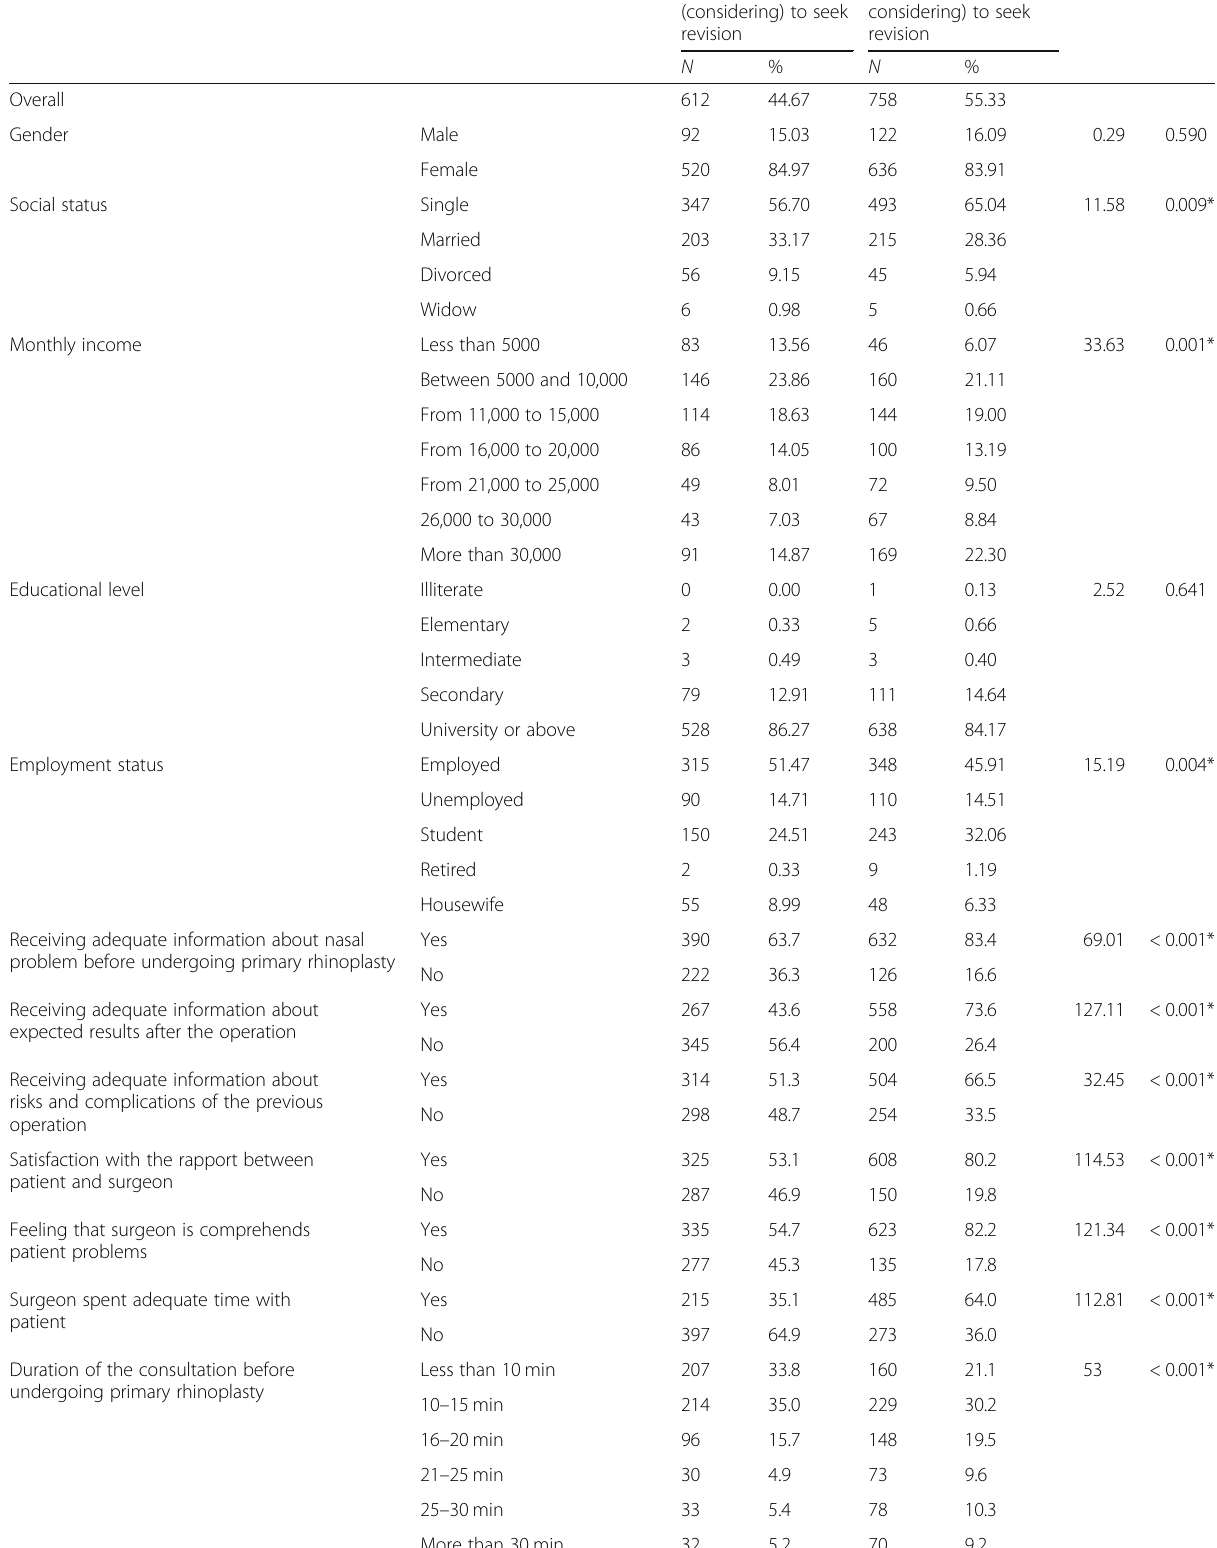
Table 4 Possible factors affecting patient to consider (think) to seek revision